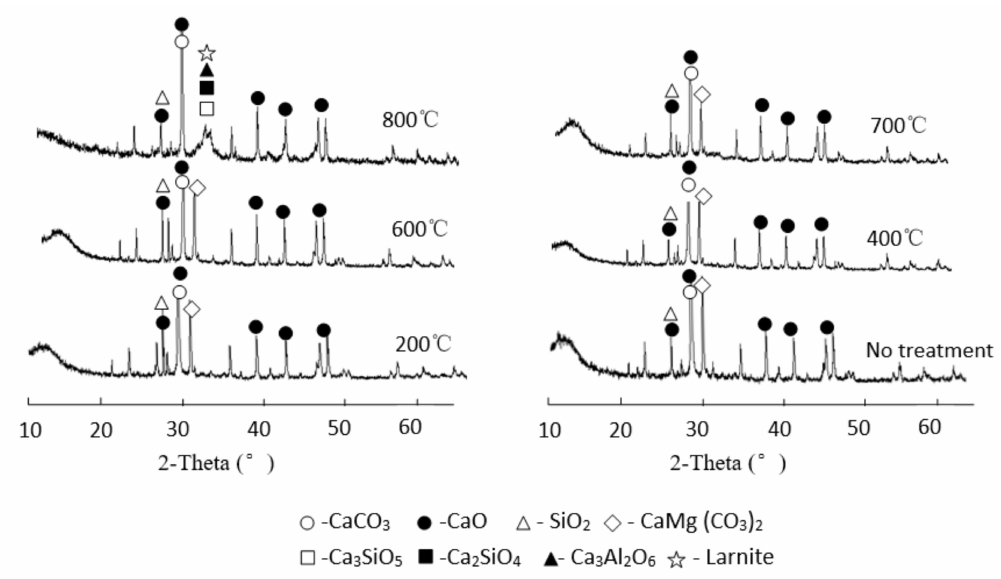
Figure 6. Mineral compositions in WCP determined by